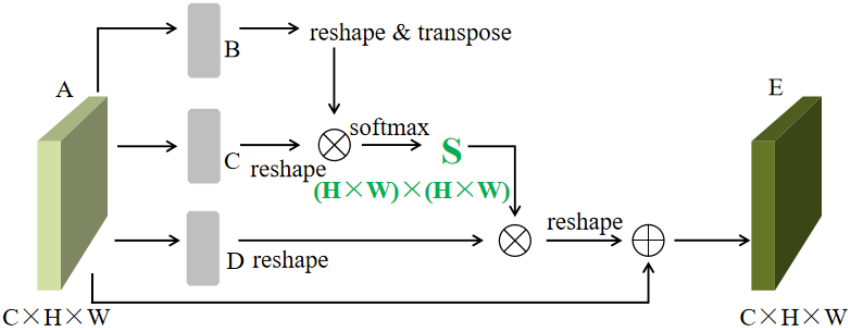
Figure 3. The structure of the position attention